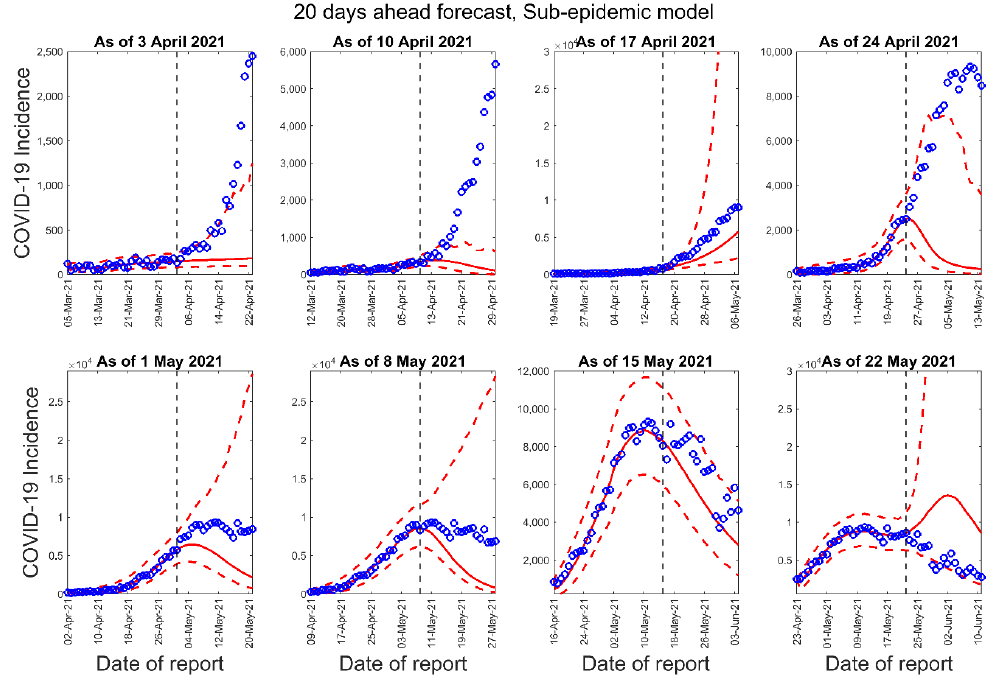
Figure 8. Twenty-days ahead forecasts of the COVID-19 epidemic curves in Nepal by calibrating the sub-epidemic model for eight different periods. Blue circles correspond to the data points; the solid red line indicates the best model fit, and the red dashed lines represent the 95% prediction interval. The vertical black dashed line represents the time of the start of the forecast period.